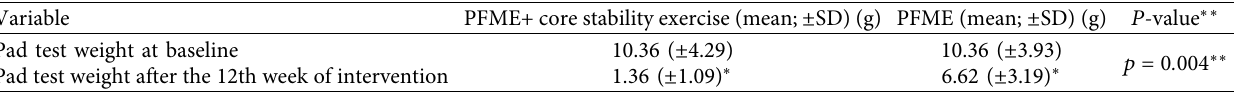
Table 3: Difference of pad weight in between the study groups after the 12th week of intervention.